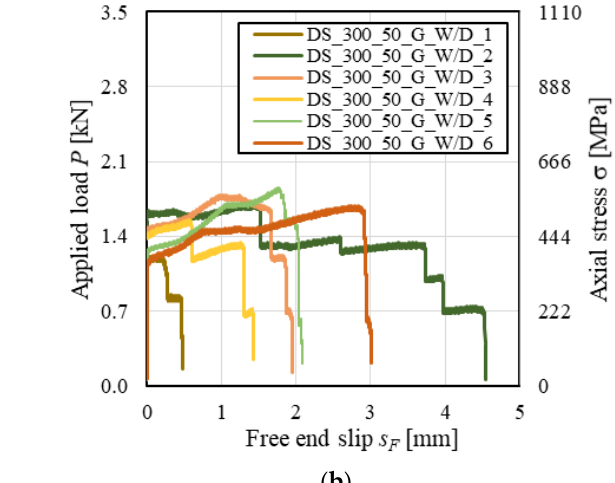
Figure 10. MD mf R failure ( a ) within the bonded length (specimen DS_300_50_G_W/D_1) and ( b ) outside the bonded length (specimen DS_300_50_G_W/D_2).